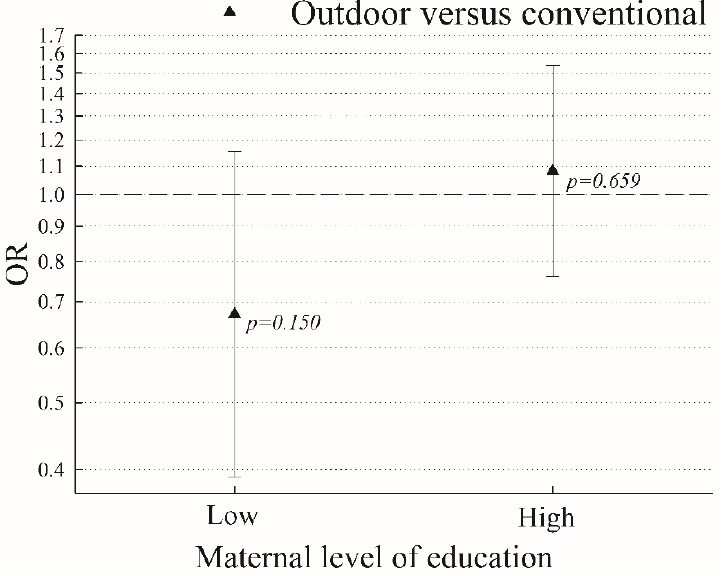
Figure 1. Adjusted odds ratios (OR) for motor skills test results among children from outdoor versus conventional kindergartens stratified by maternal education level.